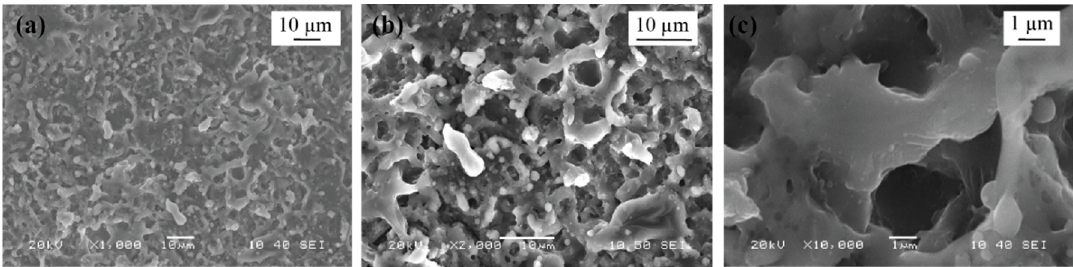
Figure 2. Micro-structure formed on the surface after three passes of air plasma treatment. Samples